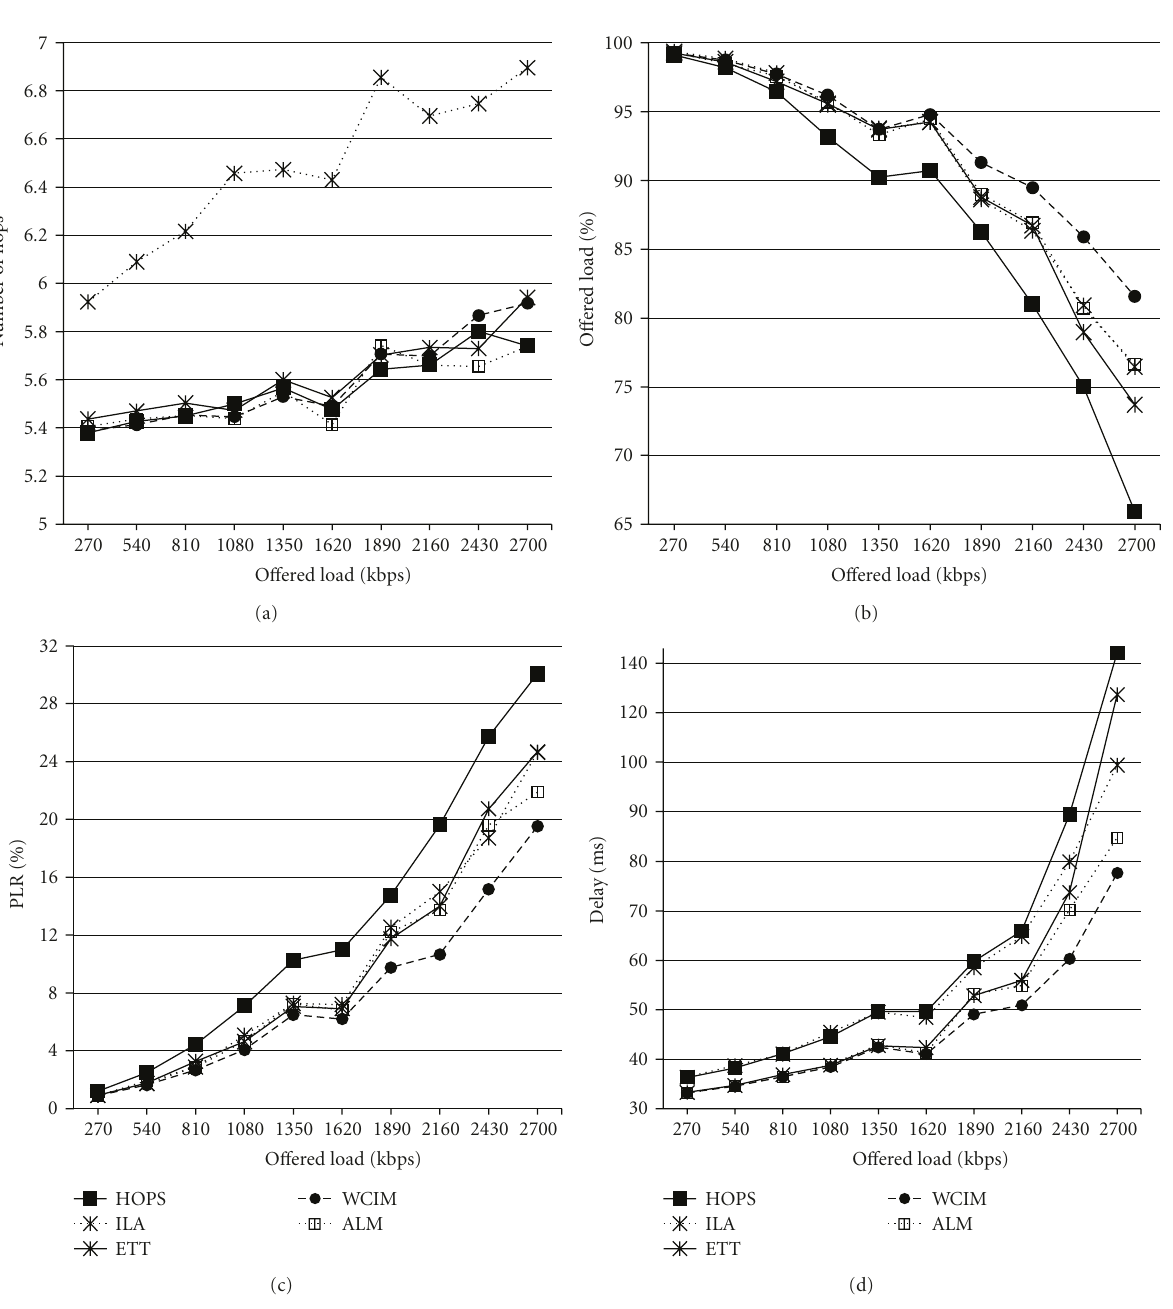
Figure 6: Scenario 1 main results. (a) Average route length. (b) Goodput. (c) Packet loss rate. (d) End-to-end